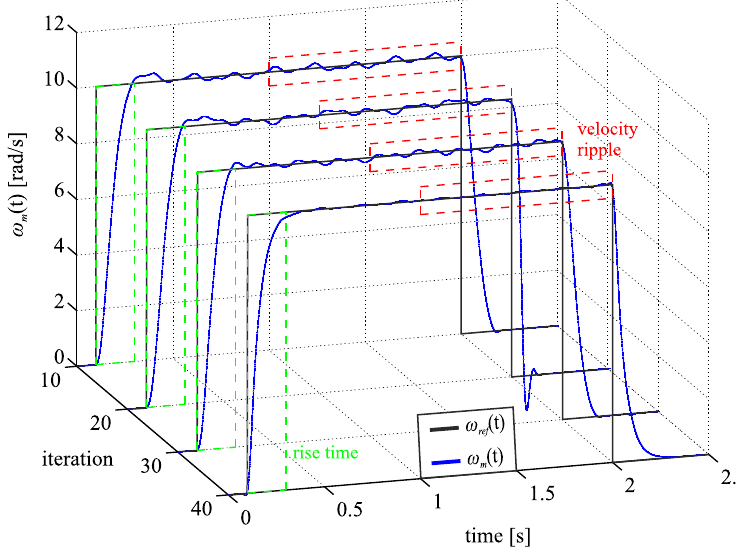
Figure 3. Experimental results of the velocity response during tuning procedure for selected iterations.